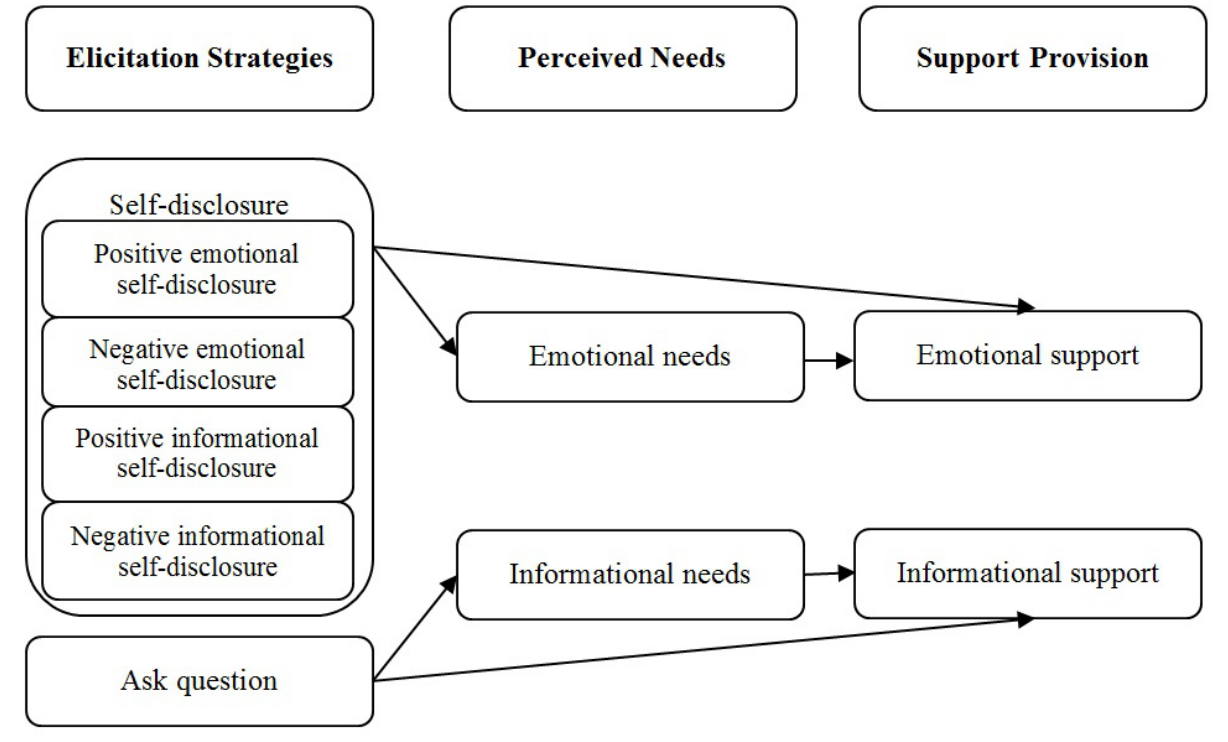
Figure 1. Conceptual model of social support elicitation and